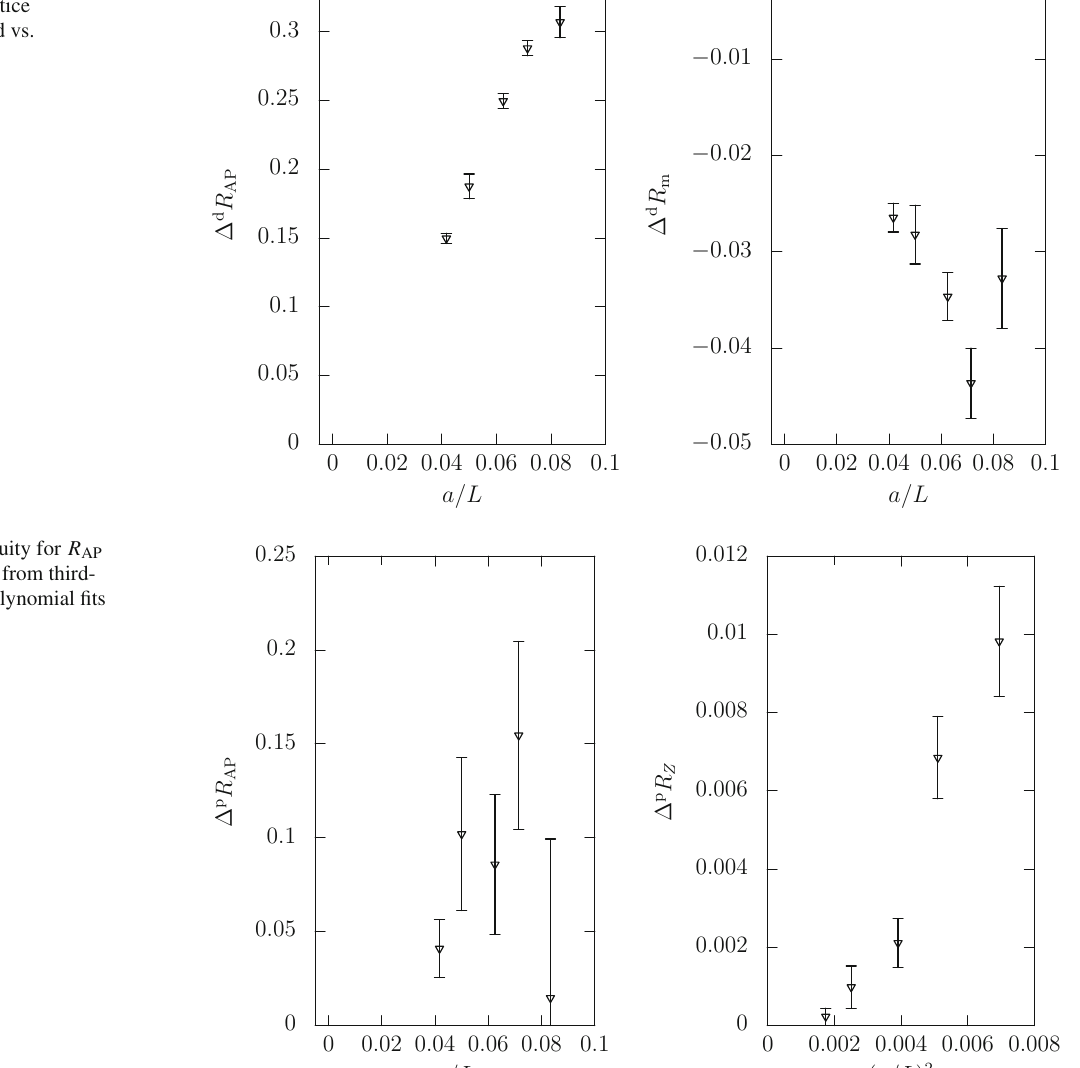
Fig. 4 O ( a ) ambiguities of R AP and R m due to different definitions of the lattice derivative (improved vs. standard)